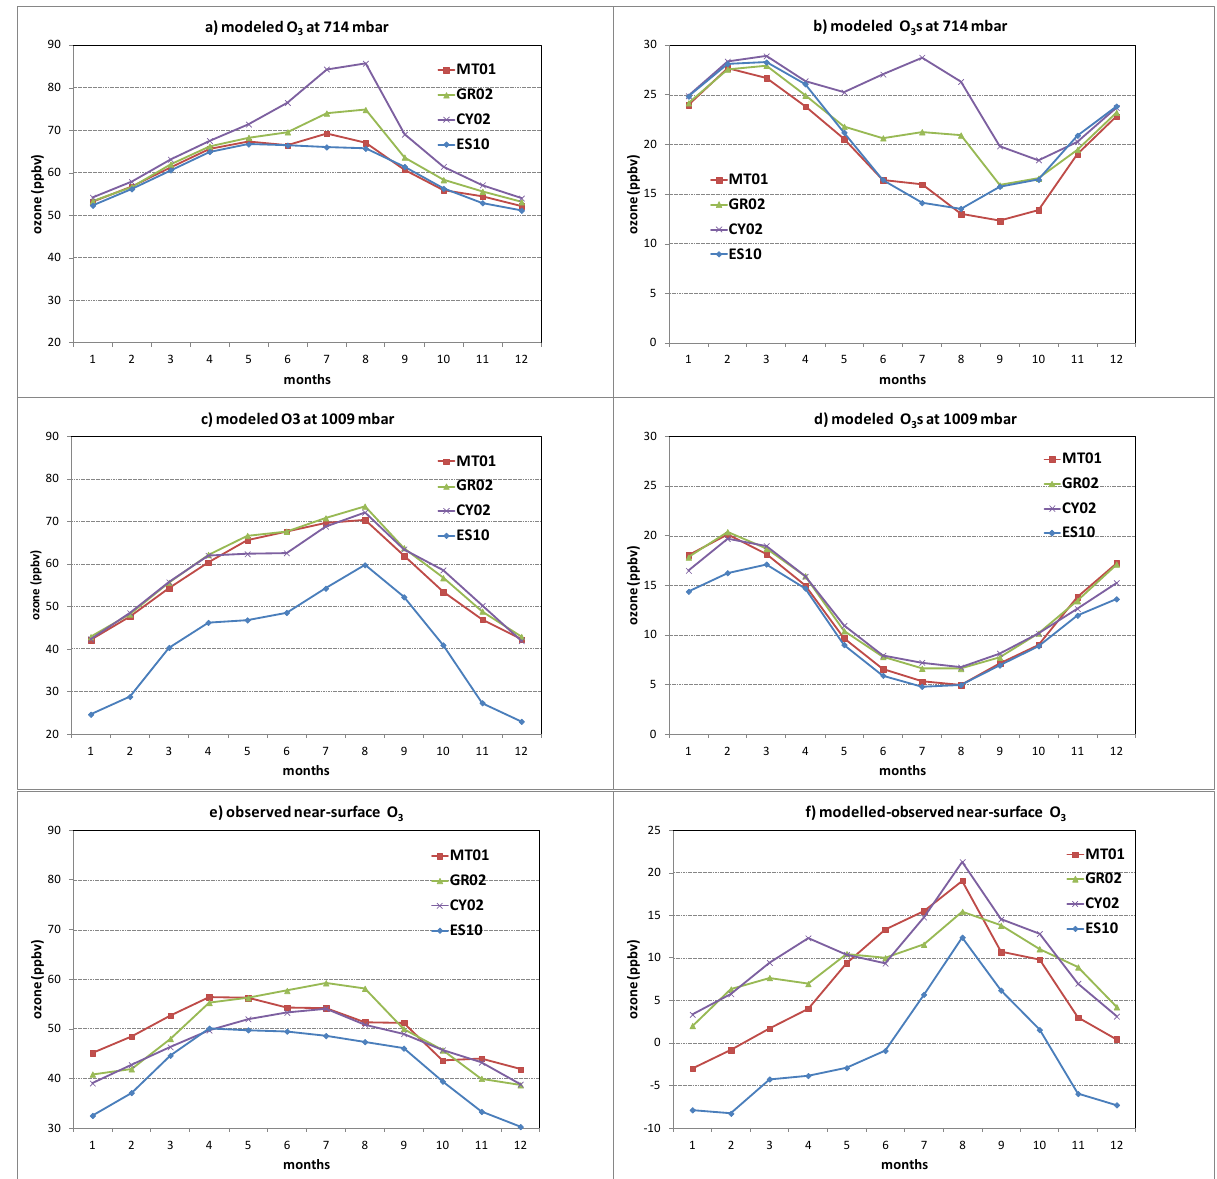
Figure 8. Mean seasonal cycle over the period 1998-2008 of EMAC simulated ozone 926 Fig. 8. Mean seasonal cycle over the period 1998–2008 of EMAC-simulated ozone (ppbv) and stratospheric ozone tracer O3s (ppbv) at 714hPa (a, b) and at 1009hPa (c, d) as well as observed near-surface ozone (e) and the difference between modelled and observed near- (ppbv) and stratospheric ozone tracer O3s (ppbv) at 714 hPa (a, b) and at 1009 hPa (c, 927 surface ozone values (f) at the stations Gozo, Malta (MT01, red); Finokalia, Greece (GR02, green); Ag. Marina, Cyprus (CY02, purple); and Cabo de Creus, Spain (ES10, light blue). For the EMAC-simulated data the closest grid cell to the station coordinates was selected. d) as well as observed near surface ozone (e) and the difference between modelled 928 by the larger amplitude of the seasonal cycle of near-surface and observed near surface ozone values (f) at the stations Gozo, Malta (MT01, red), 929 ozone in EMAC compared to observations and the fact that the model bias (modelled–observed near-surface ozone Finokalia, Greece (GR02, green), Ag. Marina, Cyprus (CY02, purple) and Cabo de 930 monthly values) has a seasonal behaviour with the highest biases attained during summer (Fig. 8f). This discrepancy is Creus, Spain (ES10, light blue). For the EMAC simulated data the closest grid cell to 931 related to the coarse horizontal grid resolution of the model version used (250–300 km), which artificially mixes ozone the station coordinates was selected. 932 precursors, notably NO x , over a large volume, whereas in